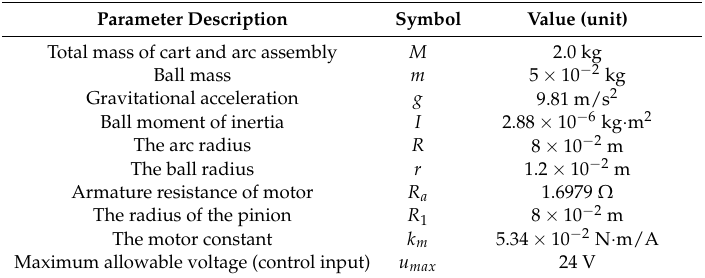
Table 3. The numerical values of the ball–arc system parameters [7].